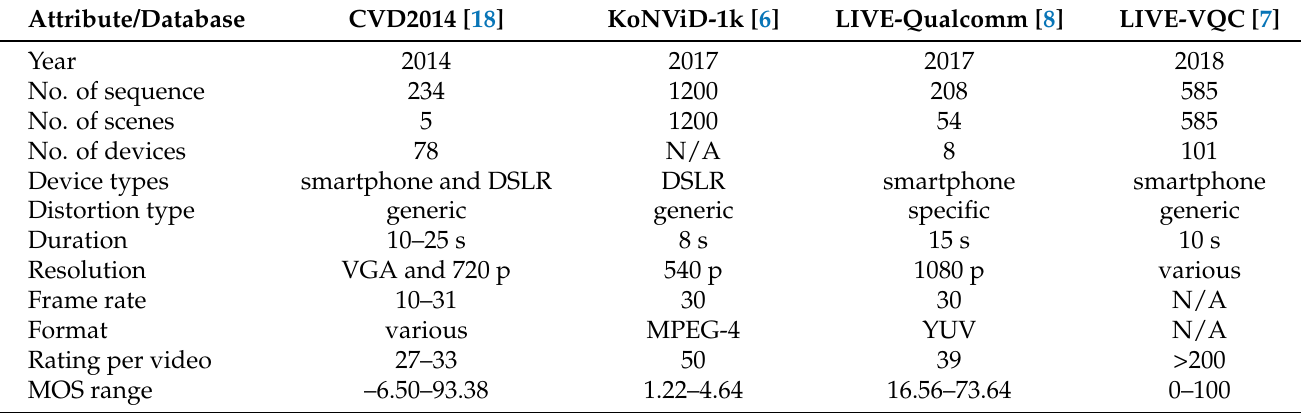
Figure 4. Sample frames of the video contents contained in the four considered databases: ( a ) CVD2014, ( b ) KoNViD-1k, ( c ) LIVE-Qualcomm, and ( d ) LIVE-VQC. Table 1. Overview of the publicly available databases for in-the-wild video quality assessment. In the column Device types : “DSLR” stands for Digital single lens